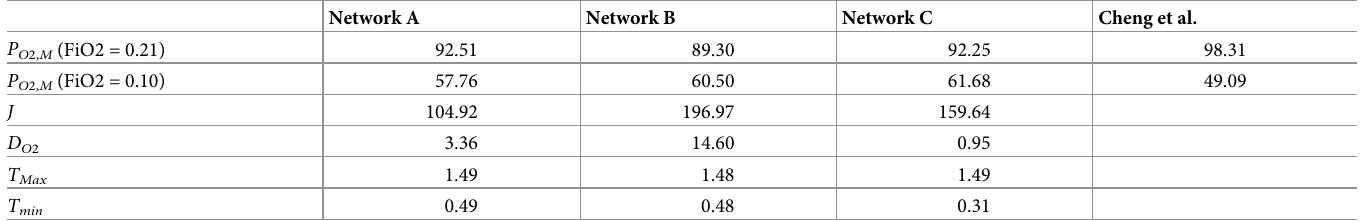
Table 2. Results from BELUGA Genetic Algorithm. The top block contains oxygen tensions from Cheng et al., and most fit individuals for each network from BELUGA optimization. The middle block contains the value of our objective function for each network from the most fit individuals. The bottom block contains the best fit parame- ter values for each